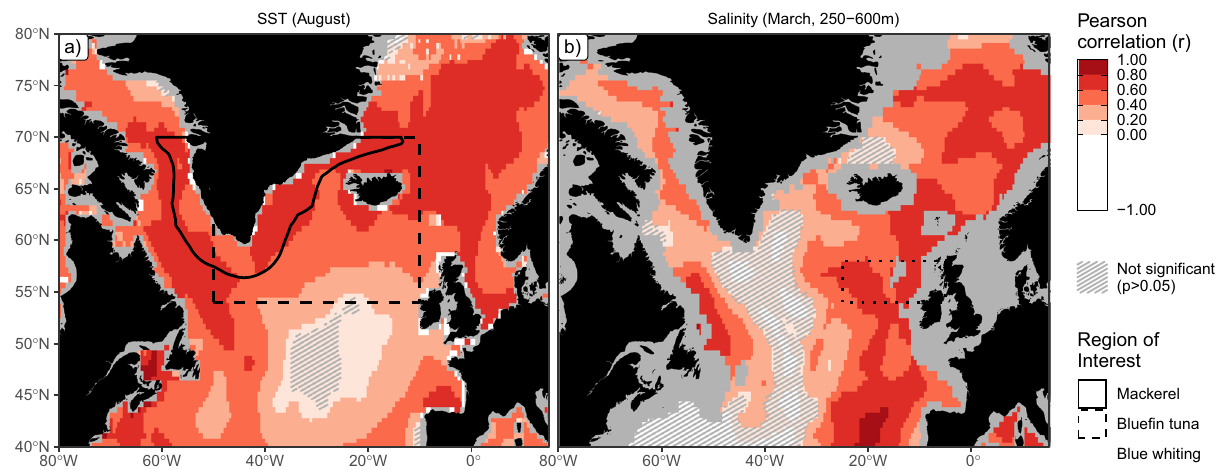
Fig. 1 Ocean state can be skilfully forecast. Predictive skill of physical variables underlying our habitat forecasts from climate prediction systems with a lead time of fi ve years for ( a ) mean August sea surface temperaure (SST) and ( b ) mean March sub-surface (250 – 600 m) salinity. Predictive skill is expressed as the Pearson correlation coef fi cient ( r ) between the forecast and observed values of each variable, with each grid point coloured according to the local value, evaluated over the period 1960 – 2018 for SST and 1985 – 2018 for salinity. Forecast skill is for the grand ensemble mean forecast, i.e., a forecast averaged across the individual realisations from all model systems. Regions where the correlation coef fi cient is not signi fi cantly greater than 0 (at the 95% con fi dence level, as estimated from bootstrapping) are cross-hatched. Lines mark the polygons over which the area of suitable habitat is calculated in subsequent analyses. Ocean regions not represented by all forecast models are shown in